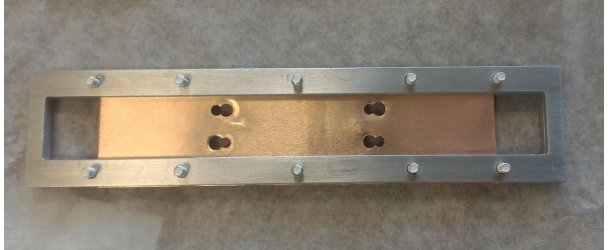
FIG. 3. Top view of the longitudinal copper slab surrounded by the aluminum frame used during the NEG deposition. The four holes are for the correct alignment of the coated slab in the DUT during THz measurements.